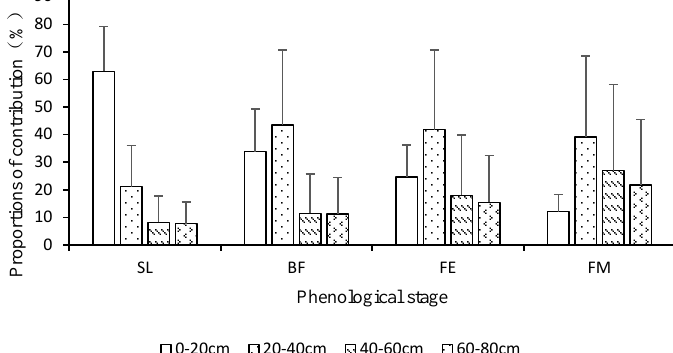
Figure 6. Proportions of soil water contributions to walnut trees during different phonological stages.